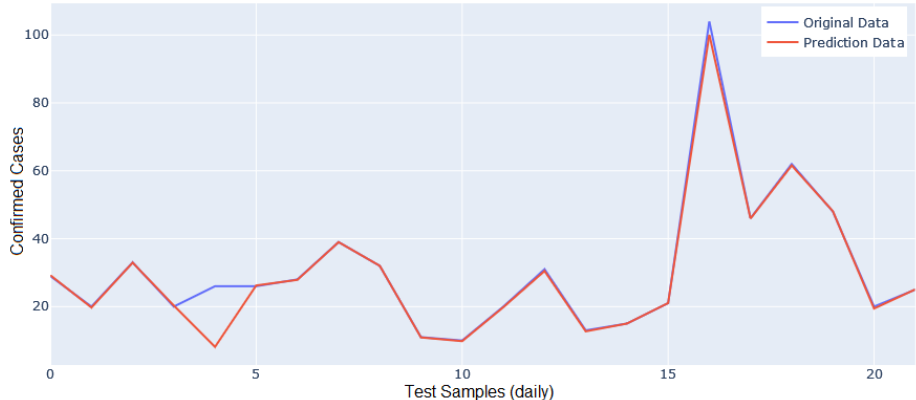
Figure 13. Prediction accuracy comparison between actual and predicted data using indoor dataset (AQIoT-3).